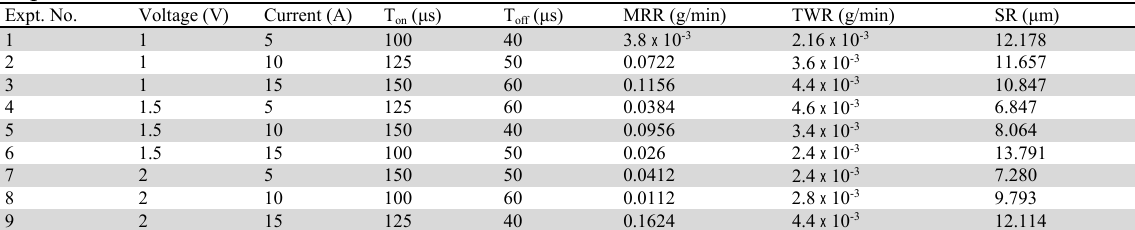
Experimental results Expt. No.